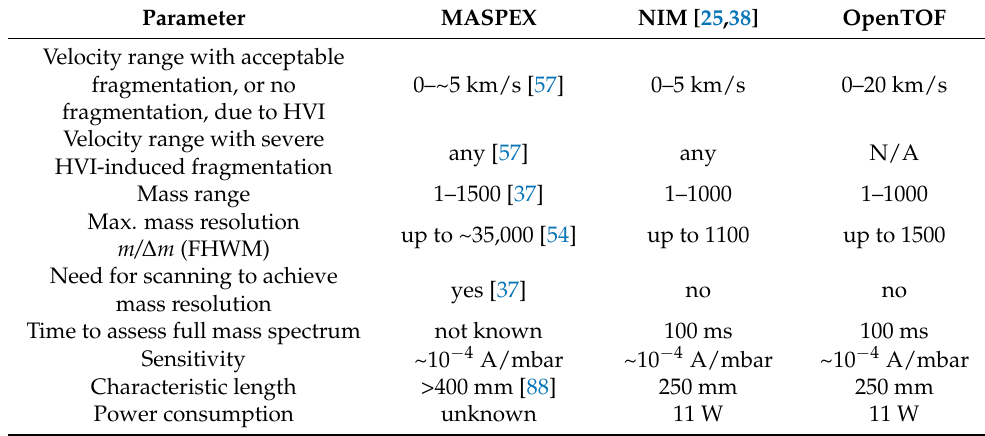
Table 2. Performance parameters of the instrument in comparison to available information of NIM/JUICE and MASPEX/Europa Clipper. Values for OpenTOF represent the findings of this